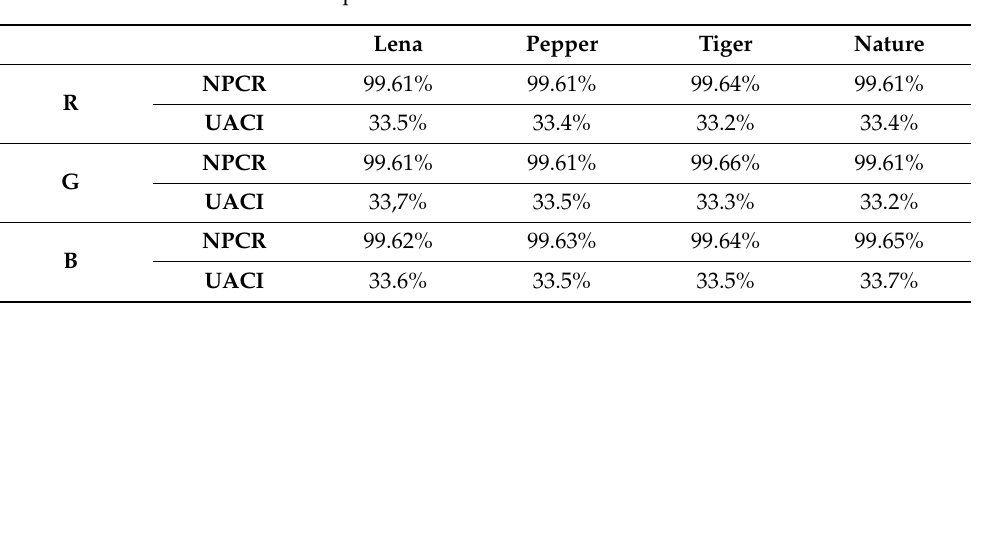
Table 7. NPCR and UACI listed output